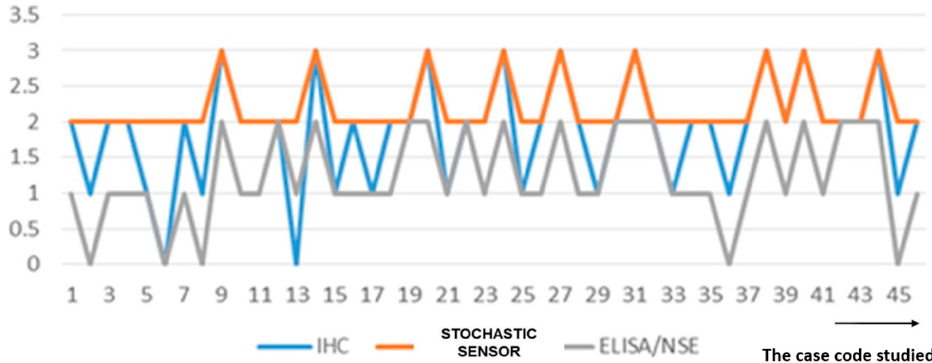
Figure 8. Correlation of the results obtained for the determination of NSE using ELISA, IHC, and the stochastic sensor.